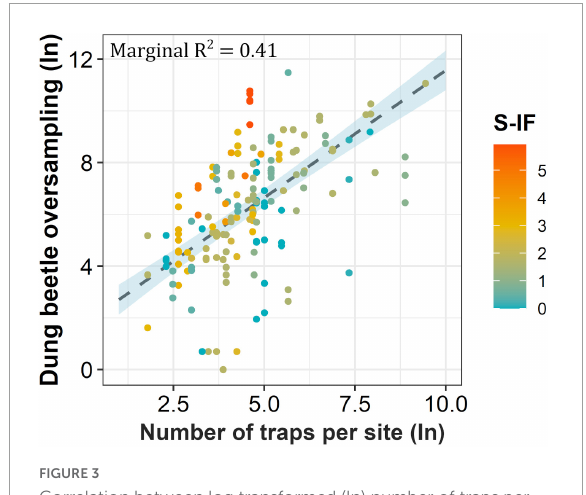
FIGURE3 Correlation between log transformed (ln) number of traps per sampling site and dung beetle oversampling. Bar colors indicate the Scopus impact factor (S-IF) of the journal where the study was published. The complete model results are shown in Supplementary Table 4B . Model fit and assumptions are shown in Supplementary Figure 2